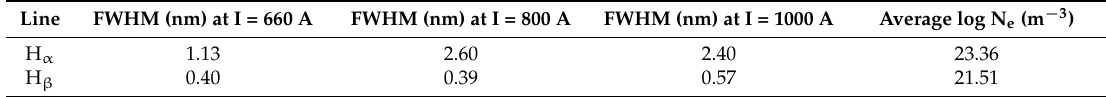
Table 4. Experimentally obtained values of FWHM of H α and H β lines (in